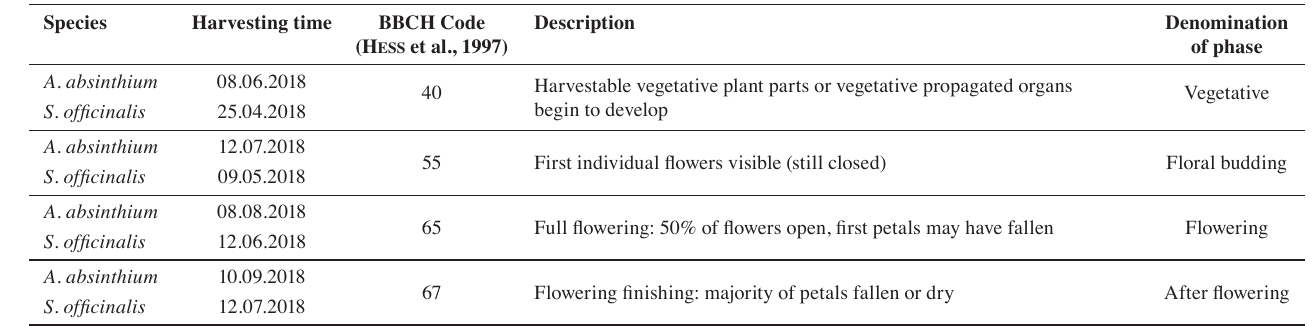
Tab. 1: Harvesting times and developmental phases of the experimental species Species Harvesting